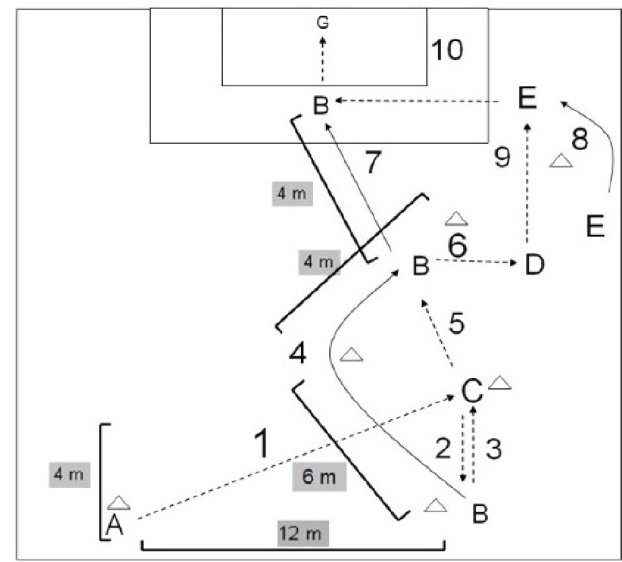
Figure 1. Tactical training illustration. Soccer players (A, B, C, D, and E). The order of events for the different soccer players (1, 2, 3, 4, and 5), and goalkeeper (G). Soccer players moving without the ball →. Ball